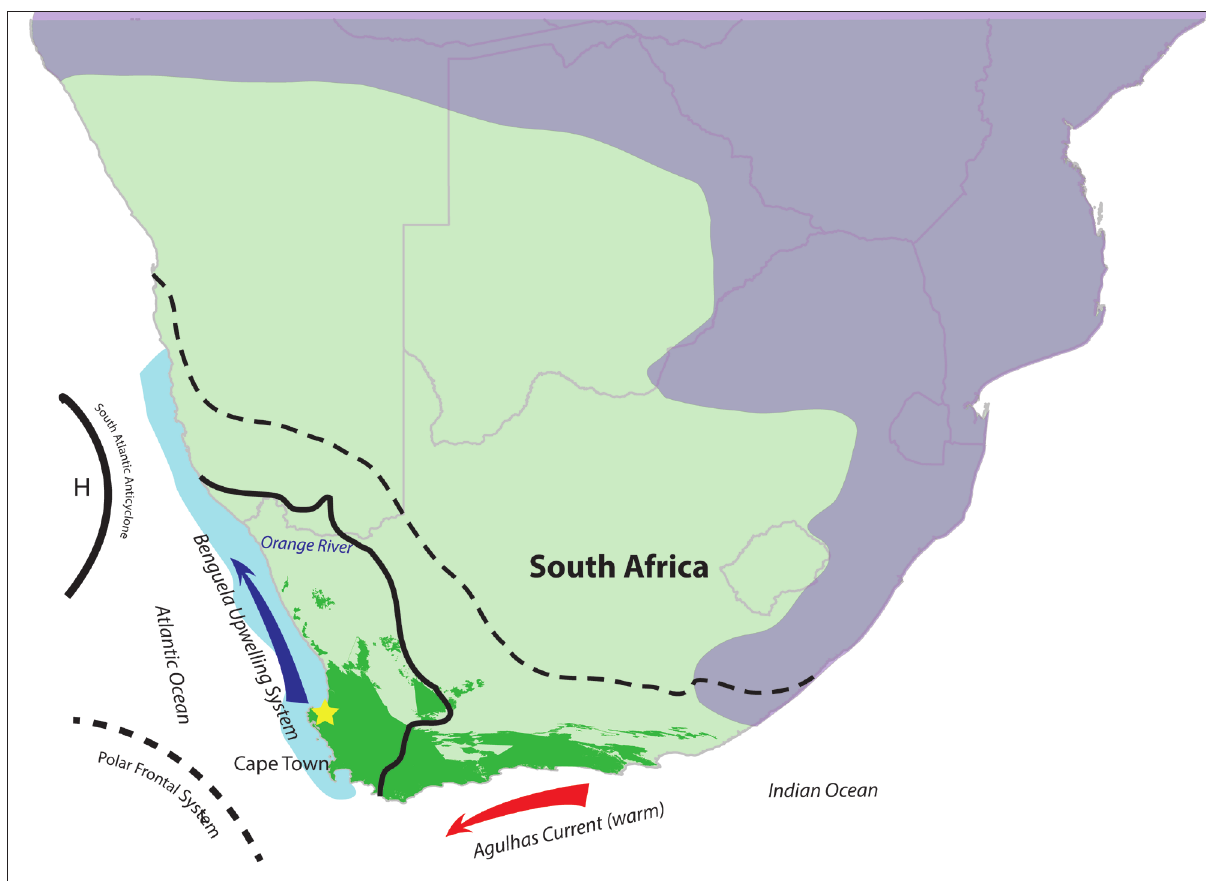
Note: Grey areas indicate the current distribution of Ptychadena taxa; the star indicates the position of Langebaanweg. The area to the left of the solid line indicates the current Winter Rainfall Zone and the area to the right between the solid and stipled lines indicates the current Year-round Rainfall Zone. To the right of the stipled line is the Summer Rainfall Zone. The Fynbos Biome is indicated in green. Rainfall zones after Chase and Meadows 3 . Figure 1: Locality of the fossil site of Langebaanweg and current climatic and oceanographic conditions at the southern tip of